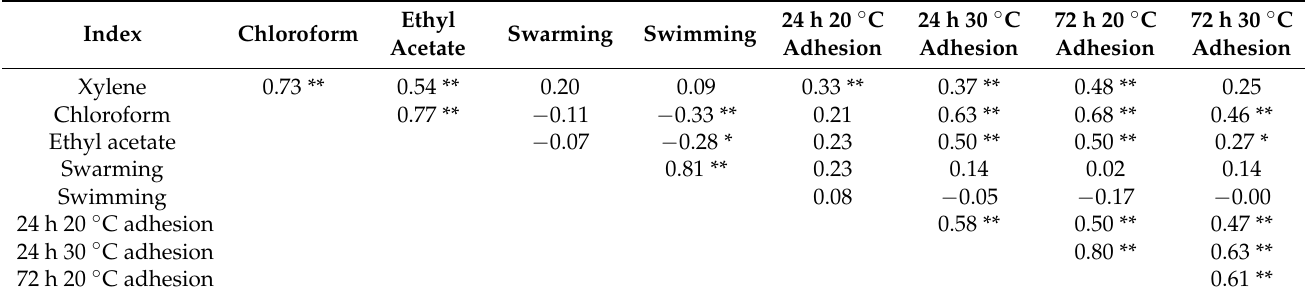
Table 2. Correlation coefficients between adhesion with cell surface characteristics of the 14